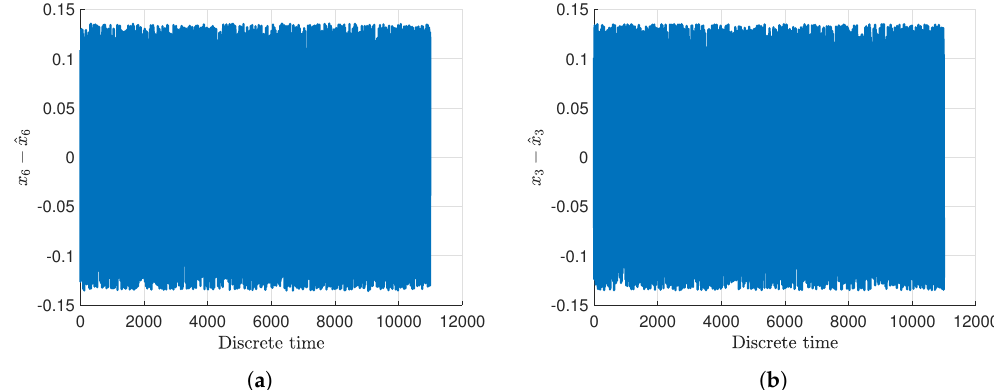
Figure 7. Evolution of the state estimation error for the rotational velocities of the main rotor ( a ) and of the tail rotor ( b ).